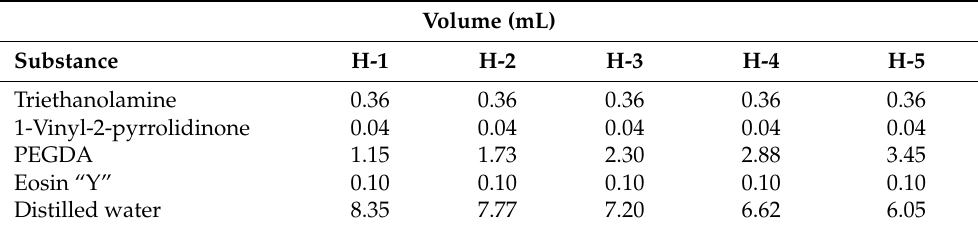
Table 2. Volume of the components used for each formulation. The solutions are filled to a volume of 10